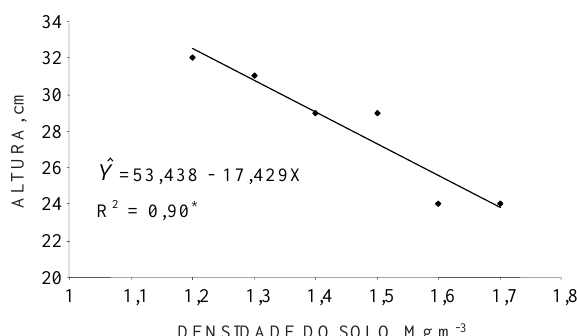
Figura 1. Relação entre a altura de plantas de cajueiro anão precoce, cultivadas em colunas de PVC, e a densidade do